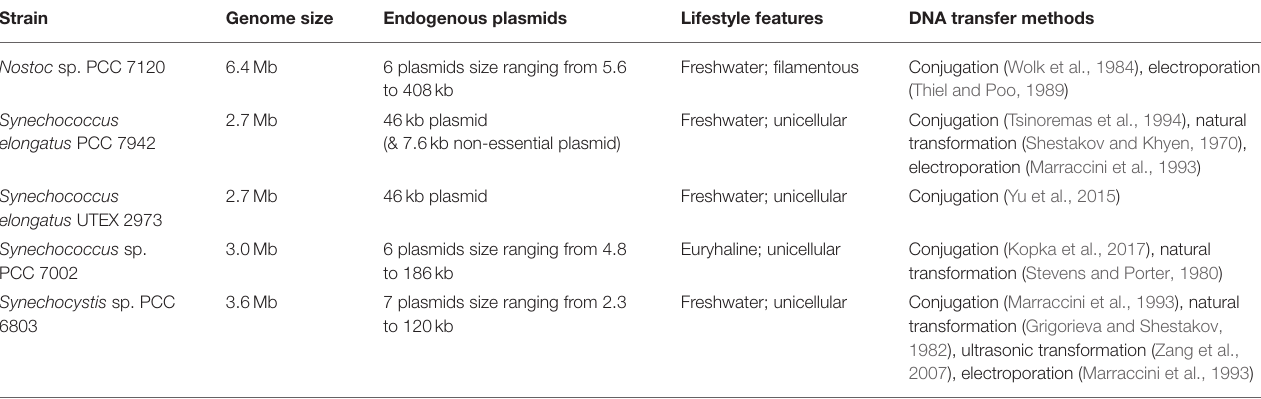
TABLE 1 | Common cyanobacterial model organisms.